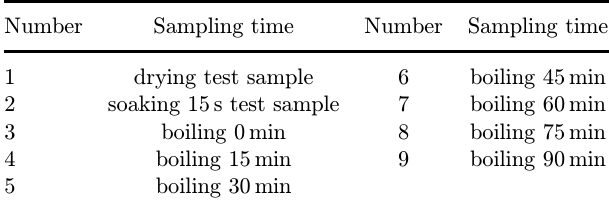
Table 1. The sampling time at di®erent